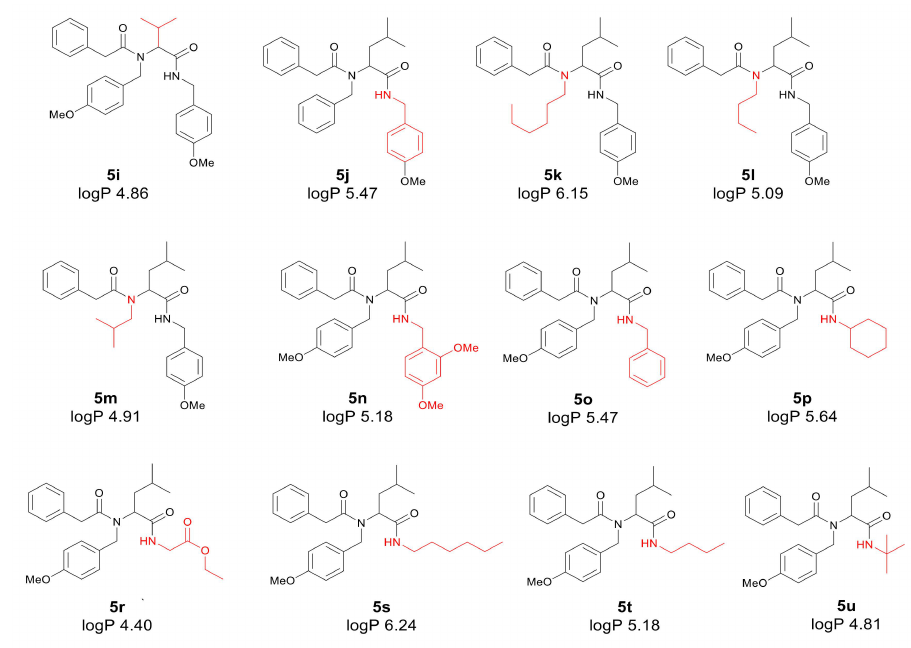
Figure 3. Products of the Ugi reaction. The compounds were isolated via column